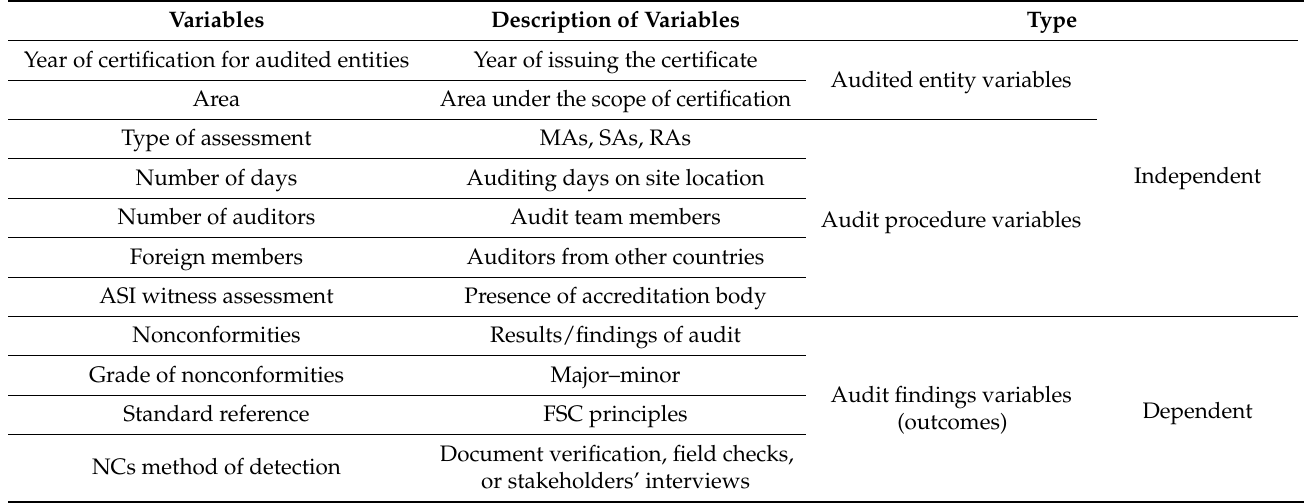
Table 1. Variables use for